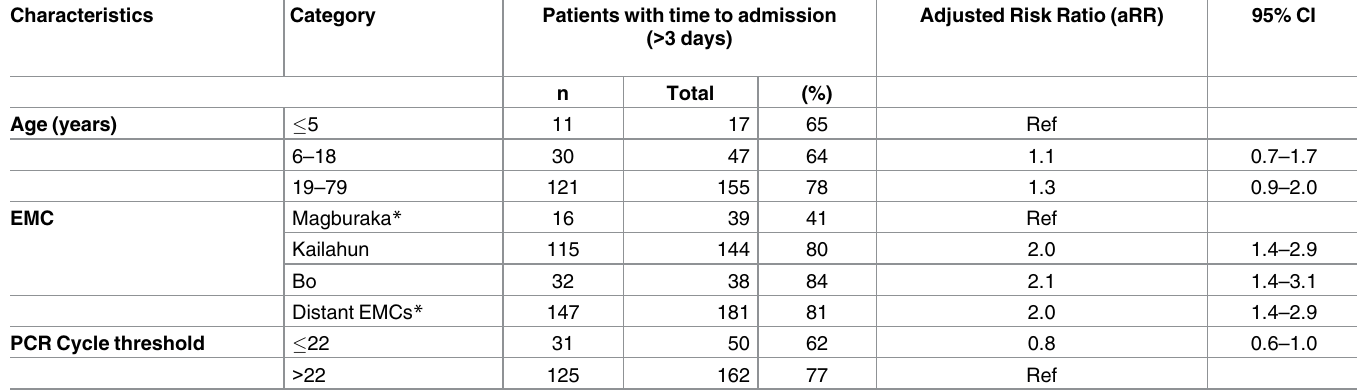
Table 3. Time to admission ( > 3 days) to Ebola Virus Disease(EMC) by selected characteristics, Tonkolili, Sierra Leone, 2014–2015, (final binomial regression model).